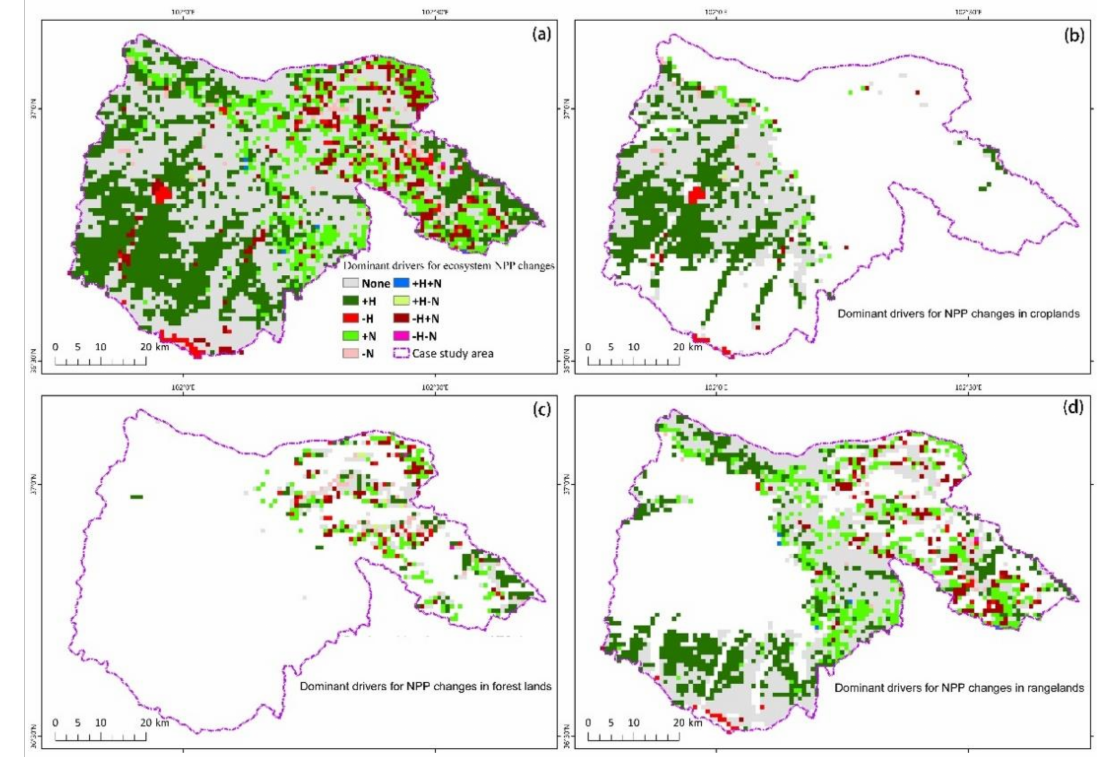
Figure 8. Dominant drivers of ecosystem NPP changes in the case study area from 2000 to 2017. The dominant drivers in ( a ) entire case study area, ( b ) croplands, ( c ) forest lands and ( d ) rangelands, respectively. “None” refers to no significant driver. H and N represent human activity and natural forces as driving factors, respectively. “+” means that the driving factor facilitated the improvement of the ecosystem and relieved the degradation of ecosystem. “-” means that the driving factor inhibited the improvement of ecosystem and accelerated degradation of